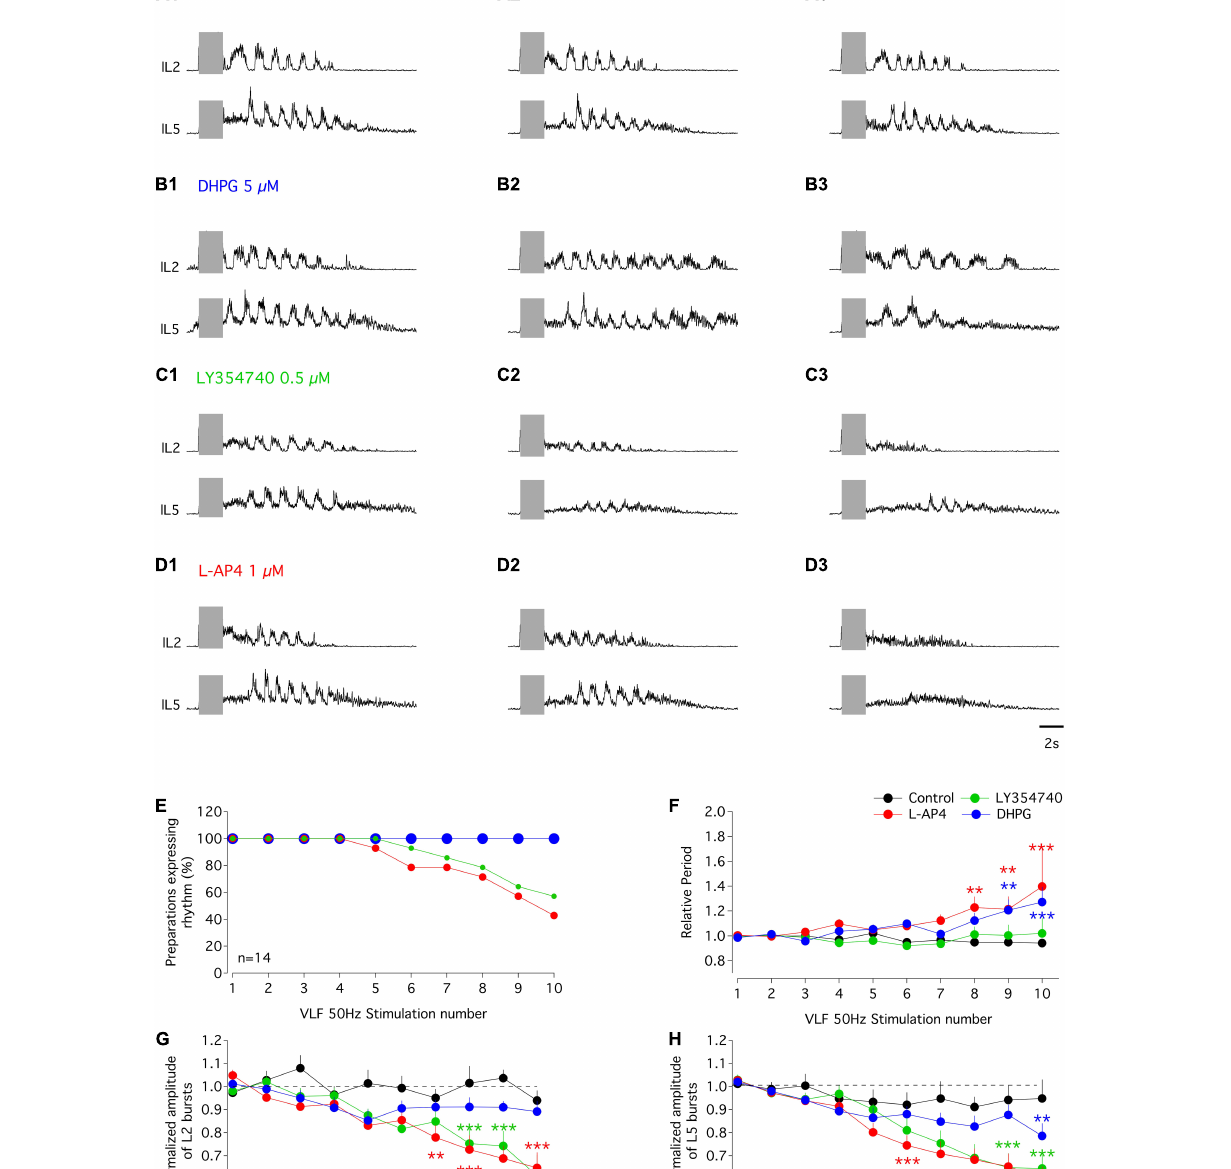
Frontiers in Cellular Neuroscience |